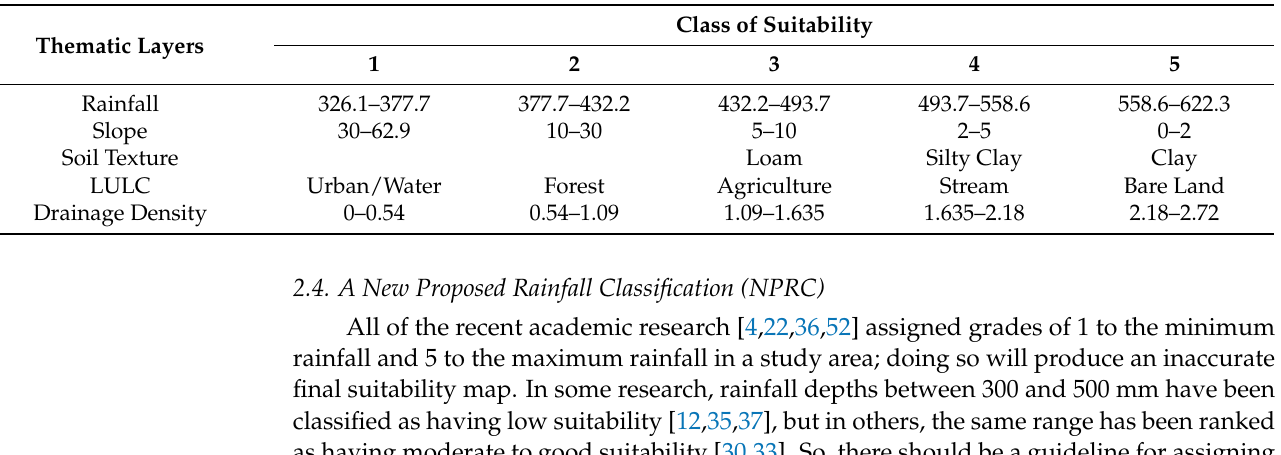
Table 3. Classification of the layers according to their degree of